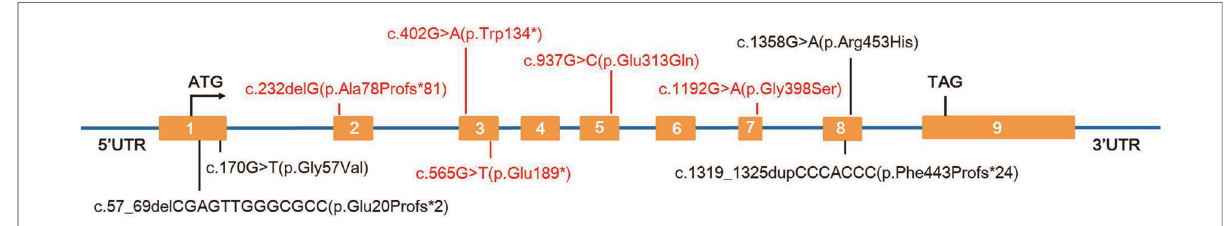
FIGURE 3 Schematic presentation of the CYP27B1 gene with the localization of the nine different variants found in this study. Red color highlights the novel variants, while black color stands for known pathogenic variants.